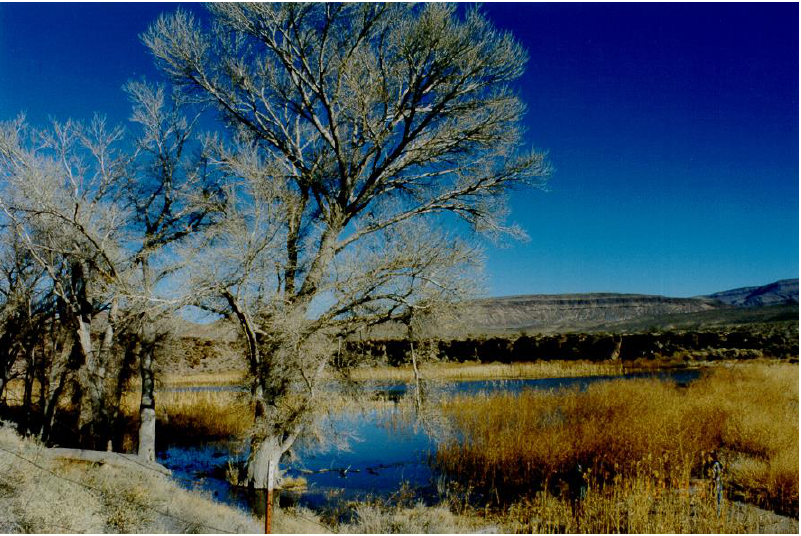
Figure 7. Wetland at edge of Black Butte (Source: Stoffle).